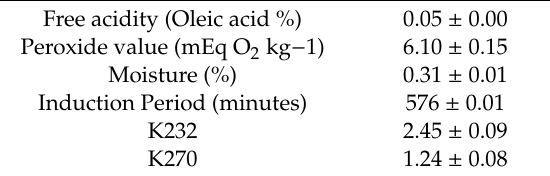
Table 2. Qualitative parameters of sunflower oil.